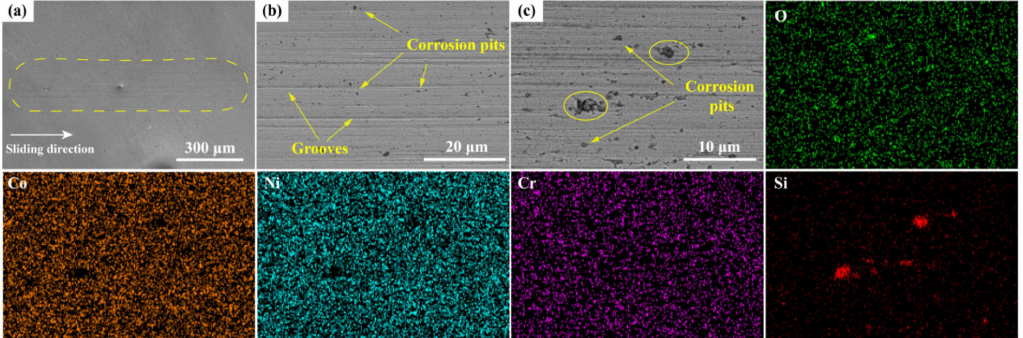
Figure 11. SEM and EDS micrographs of overall morphology ( a ) and some details ( b and c ) of the wear track for CoCrNi tested at an applied potential of 0.1